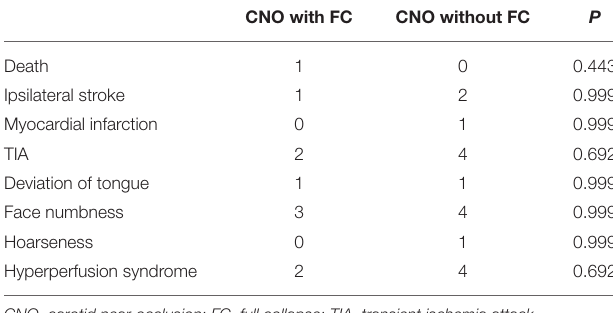
TABLE 2 | 30-day primary endpoints and peri-operative variables.